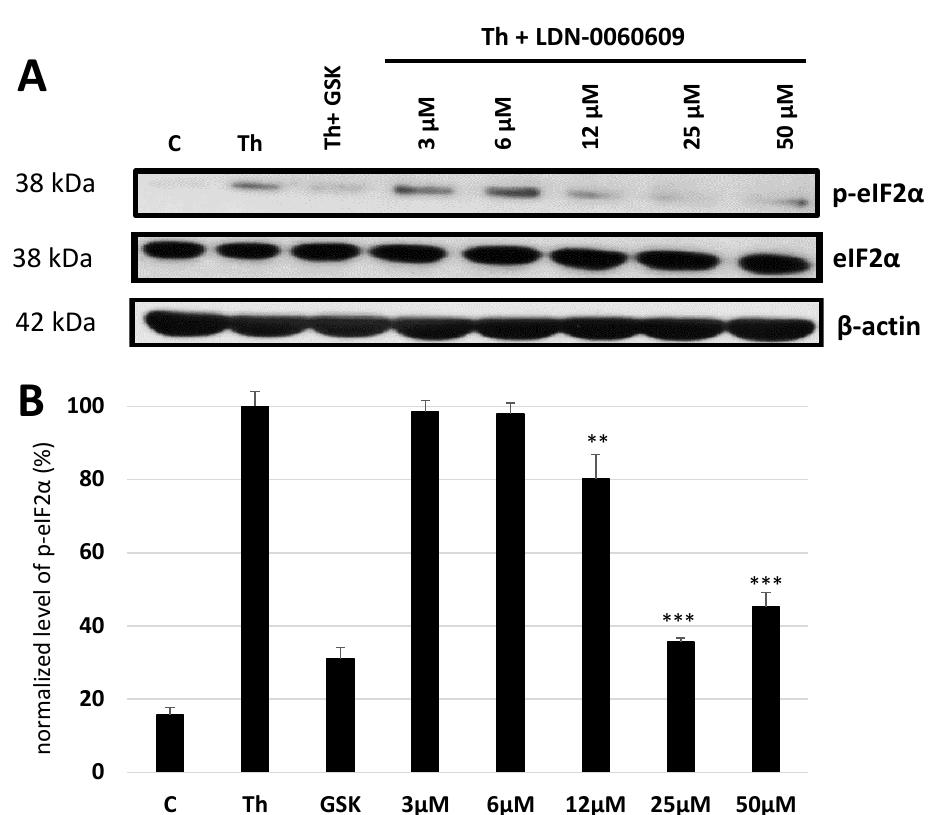
Figure 1. Analysis of the LDN-0060609 and GSK2606414 inhibitory compounds activity against eIF2 α phosphorylation by the Western blot technique ( A ) and normalized level of p-eIF2 α measured by optical densitometry ( B ). Each of the statistical analysis in individual experiments was based on the results of three independent tests. Data are expressed as mean ± SE ( n = 3). On the graphs, the differences were statistically significant as follows: ** p < 0.01, *** p < 0.001 versus the positive control (Th). C—negative control, untreated HTM cells, Th—thapsigargin.